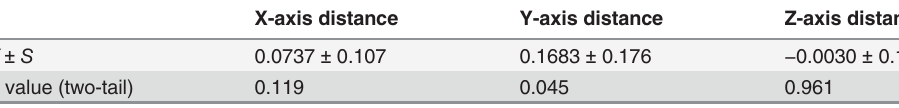
Table 5. Results of the paired-samples t -tests.